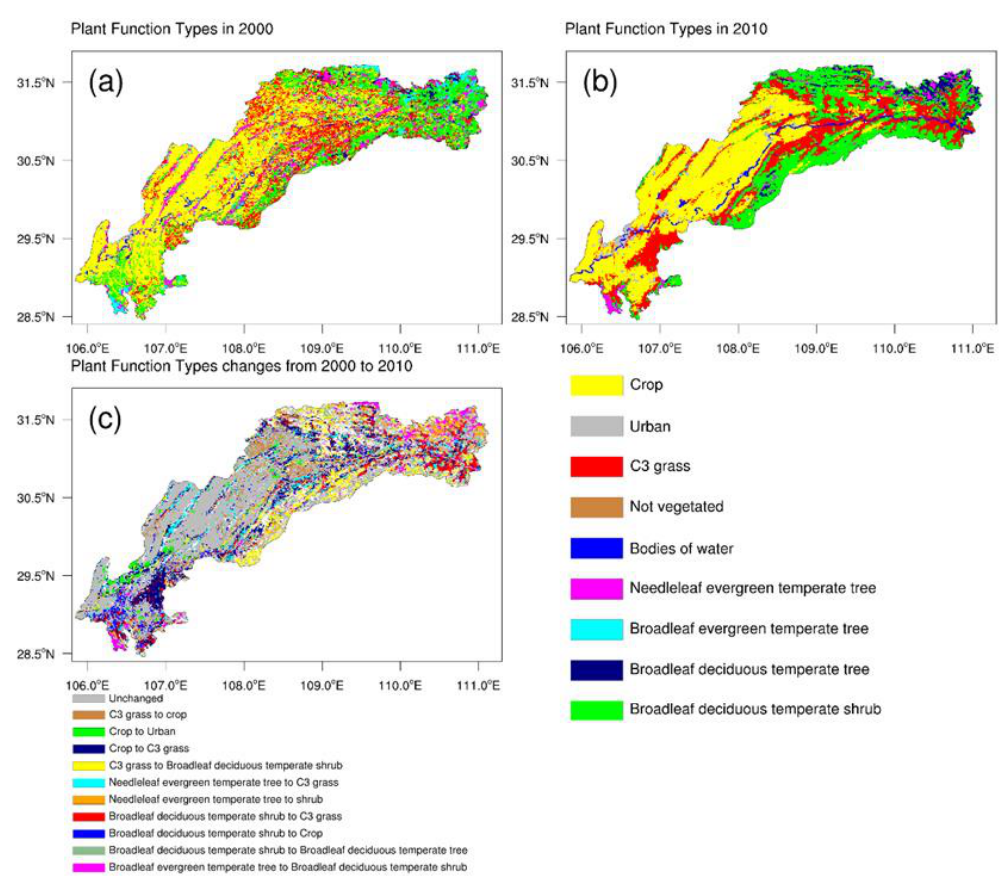
Figure 2. The plant function types (PFTs) and their conversion from 2000 to 2010.